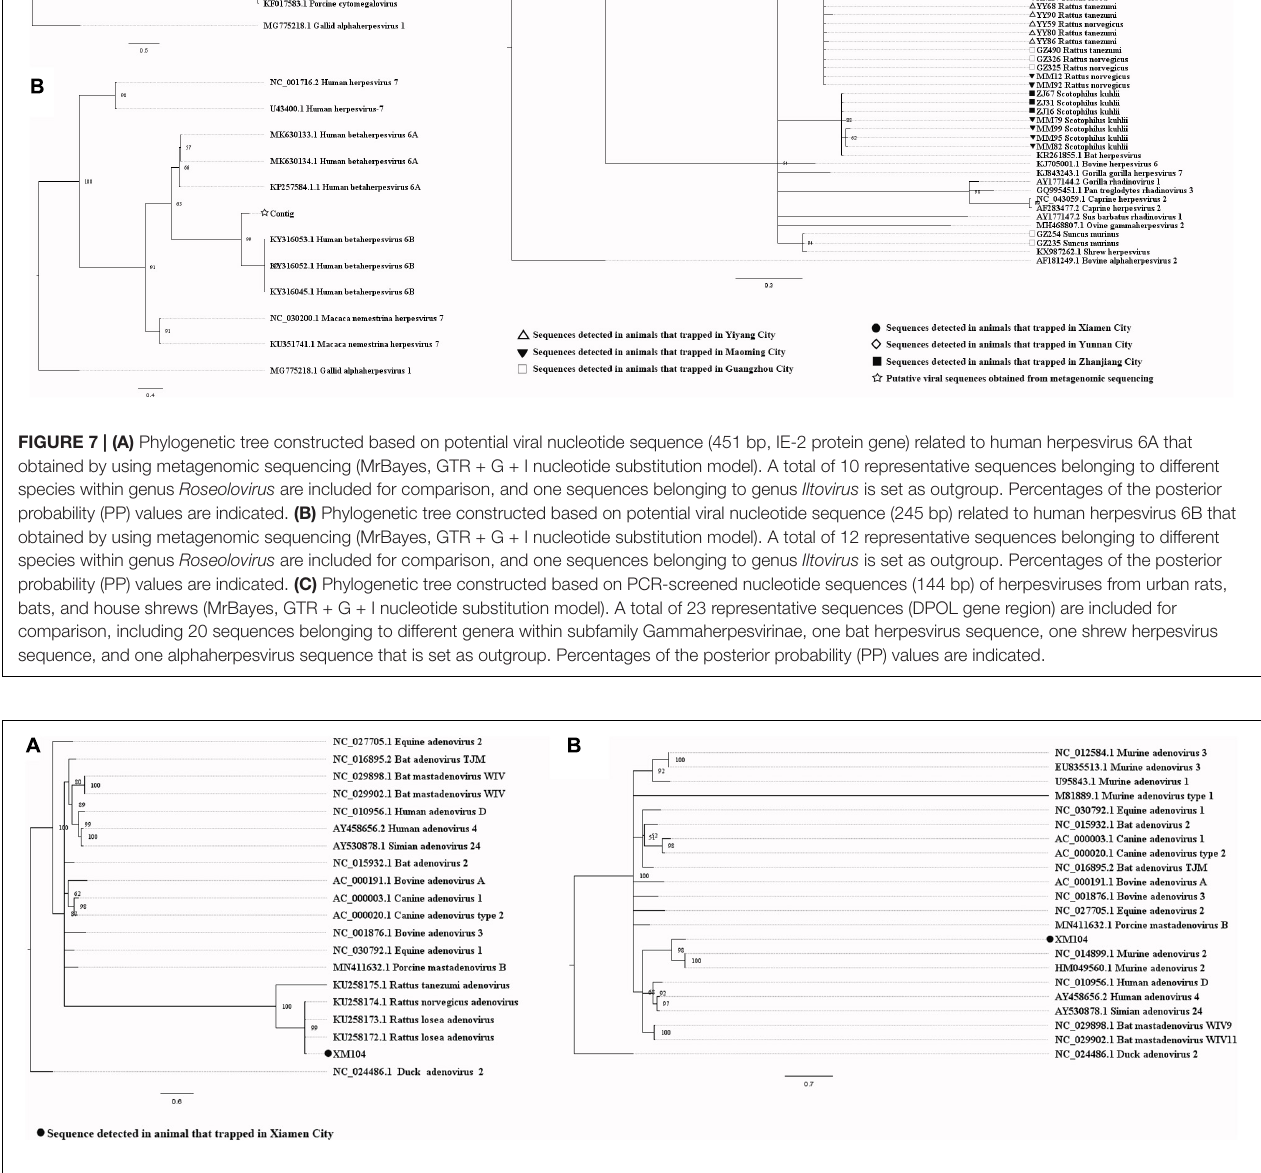
FIGURE 8 | (A) Phylogenetic tree constructed based on PCR-screened nucleotide sequence (294 bp) of adenovirus from R. losea (MrBayes, GTR + G + I nucleotide substitution model). A total of 18 representative mastadenovirus sequences and one aviadenovirus sequence (set as outgroup) are included for comparison (DNA polymerase gene region). Percentages of the posterior probability (PP) values are indicated. (B) Phylogenetic tree constructed based on the large nucleotide sequence (690 bp) of adenovirus from R. losea (MrBayes, GTR + G + I nucleotide substitution model). A total of 20 representative adenovirus sequences belonging to different species within genus Mastadenovirus and one aviadenovirus sequence (set as outgroup) are included for comparison (DNA polymerase gene region). Percentages of the posterior probability (PP) values are indicated.